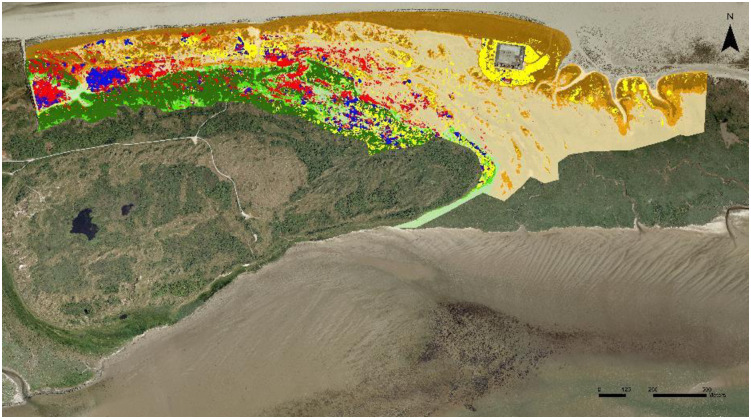
Sea-buckthorn cover changes between 1986 and 2000 (red = disappeared, yellow = appeared, blue = remained), indicating extensive mortality at low elevation in this period.The other colours represent the strata as denoted in Fig 3B. Note that the larger blue/red patches in the far west are sea-buckthorn mixed with willow species (Salix sp.).